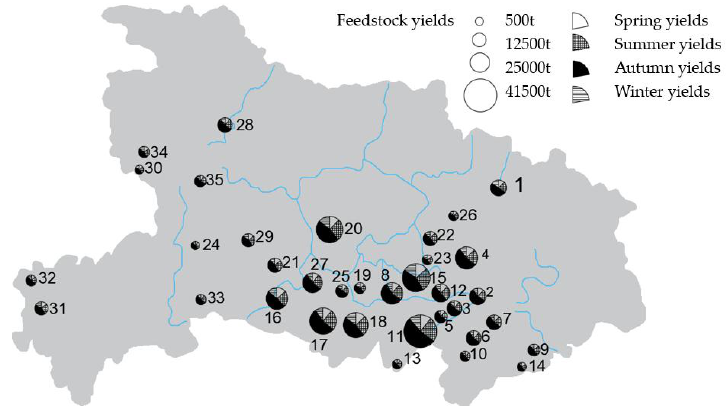
Figure 3. Geographical distributions of farmers in Hubei Province, China.